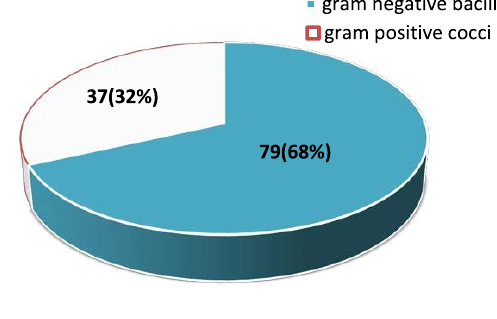
Fig. 1. Isolation of bacteria from blood